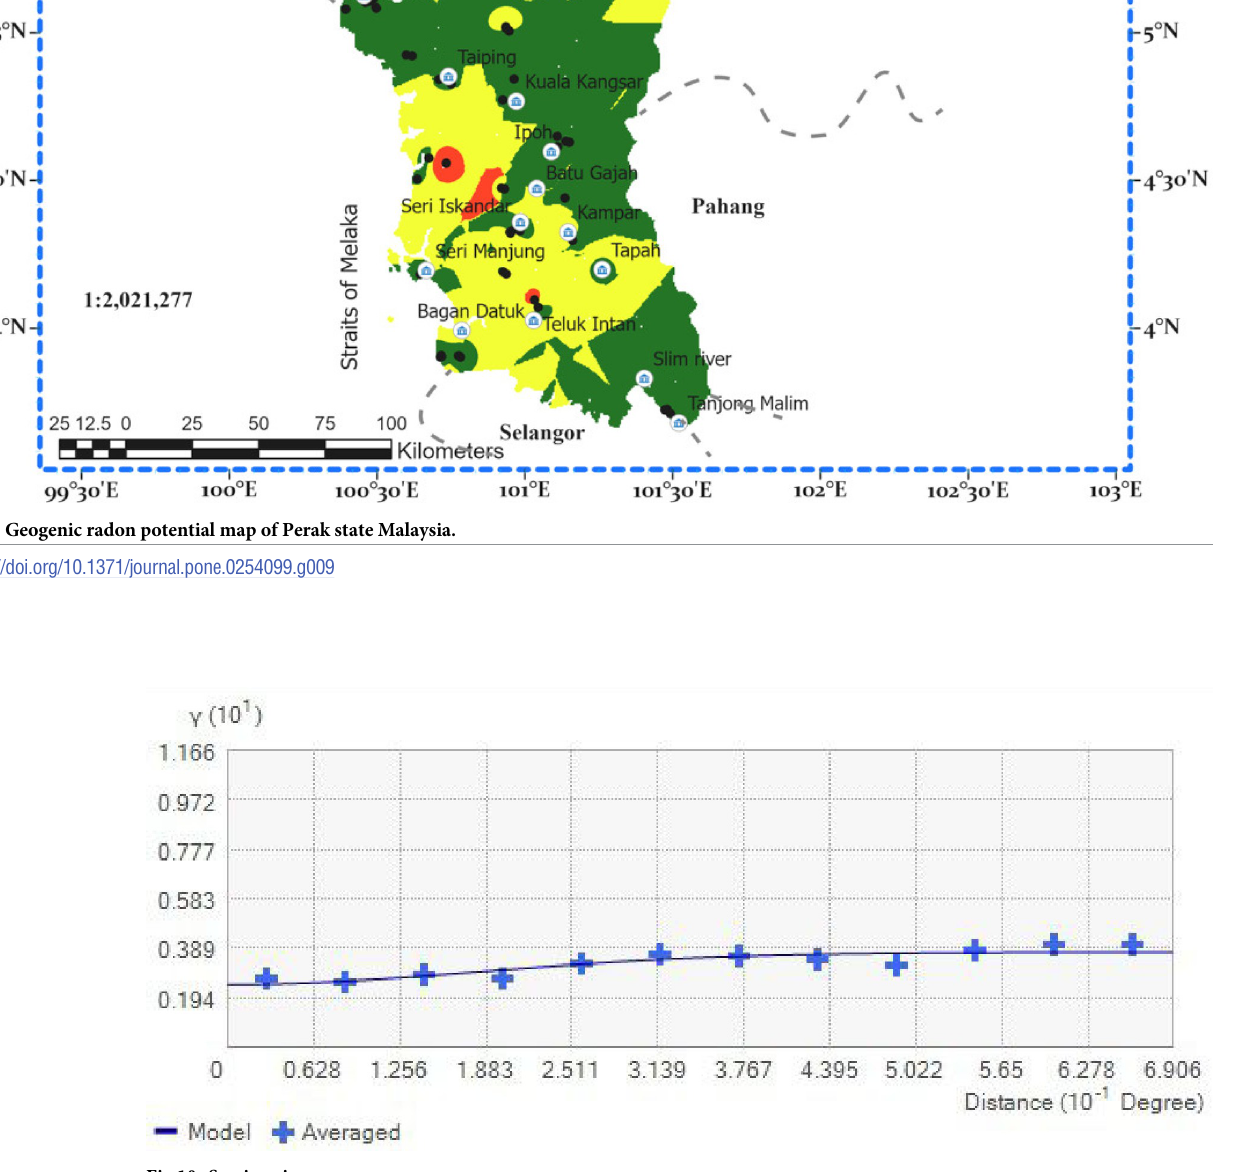
PLOS ONE | https://doi.org/10.1371/journal.pone.0254099 July 28,